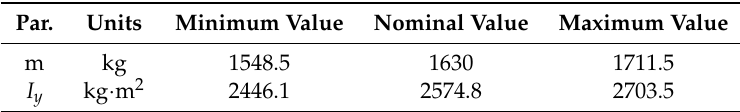
Table 3. Uncertain Parameters: mass and inertia.